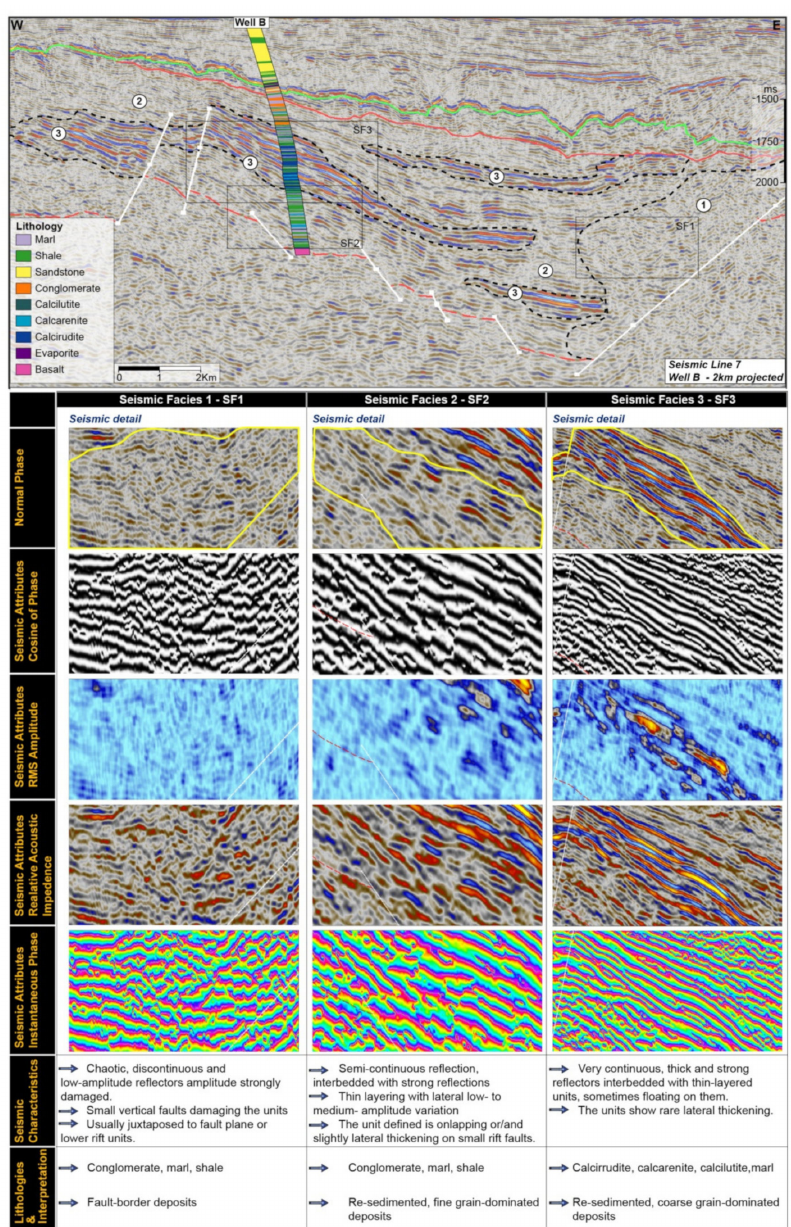
Figure 6. Seismic line III, from Figure 1B. Representative seismic section and description of the main seismic facies observed in the rift interval of the Campos